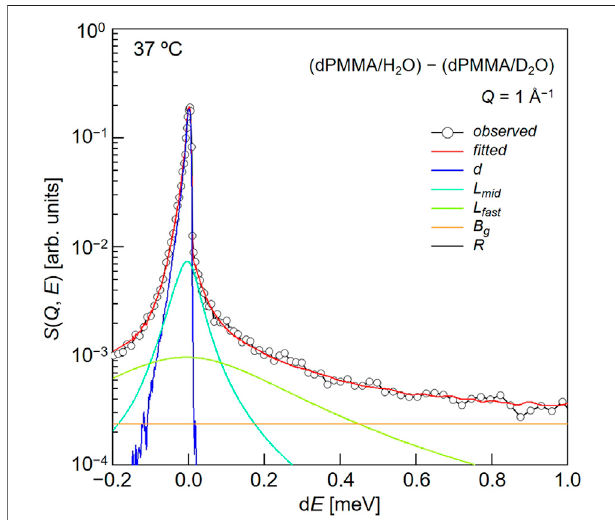
FIGURE 5 | Typical fi tting result for a QENS pro fi le obtained from the difference between dPMMA/H 2 O and dPMMA/D 2 O.